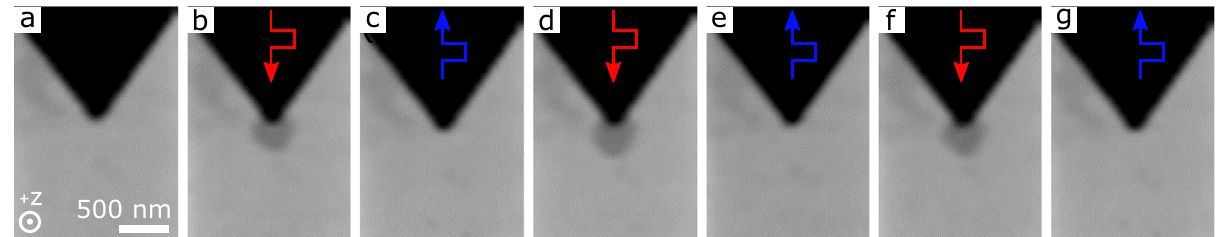
Fig. 4 | Current-induced nucleation/annihilation of SAF skyrmions. a – g Sequence of STXM images acquired at the Co edge. Before each acquisition, a single 5 ns current pulse with density J =6.2×10 11 Am − 2 is injected in the direction